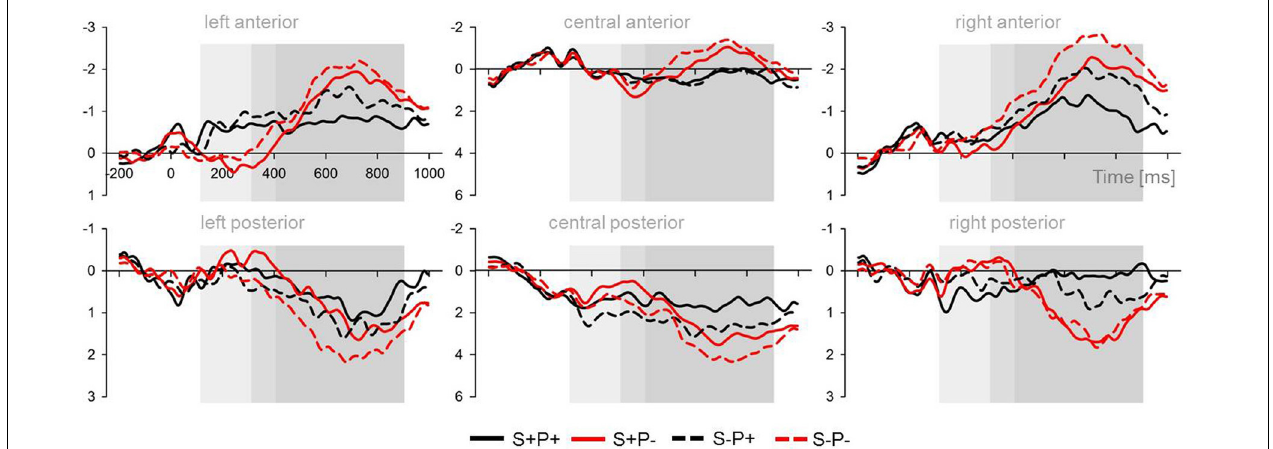
FIGURE 4 | Mean ERPs over the lateral (left and right panel) and central (middle panel) and over the anterior and posterior ROIs across all groups. The three analyzed time windows are highlighted in gray.